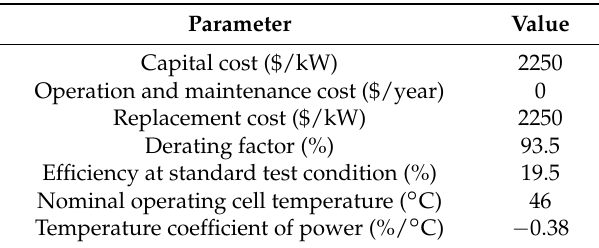
Table 1. Specifications of selected PV panel.